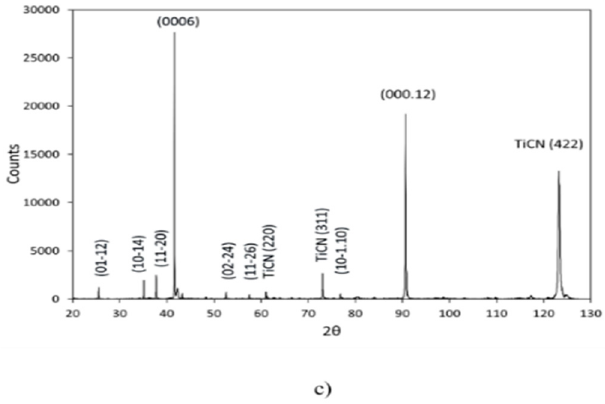
Figure 7. ( a ) Cross section SEM image α -Al 2 O 3 coating (Coating f) deposited at H 2 S / CO 2 = 0.4 onto (211)-textured MTCVD coating with optimized bonding and nucleation procedures. The uncatalyzed (H 2 S = 0) time was 30 min, resulting in the formation of fine grained α -Al 2 O 3 at the interface (arrowed). ( b ) EBSD IPF surface map. ( c ) X-ray diffractogram.